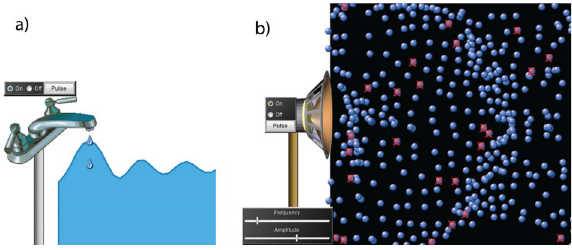
FIG. 2. (cid:1) Color (cid:2) (cid:1) a (cid:2) Side view of water wave. (cid:1) b (cid:2) Particles view of sound wave